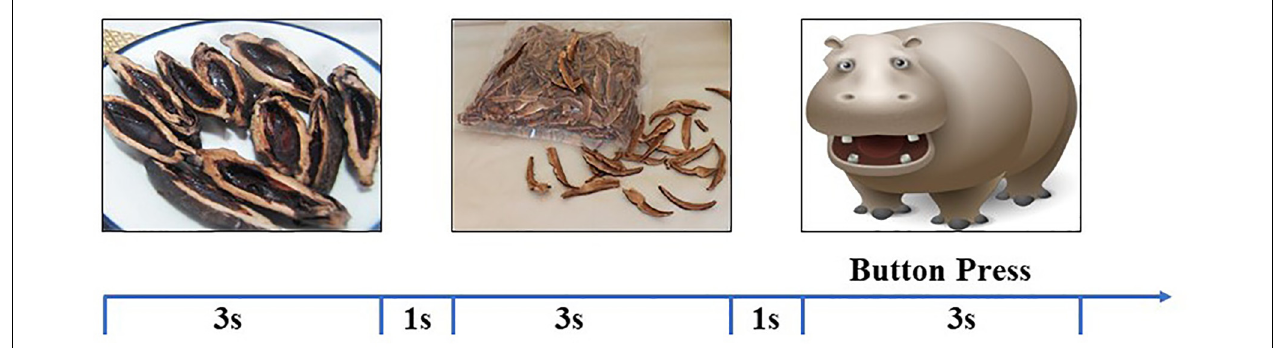
FIGURE 1 | The illustration of stimulus presentation. Different types of images [Betel quid (BQ), control, and animal] were randomly presented for 3 s with 1 s interstimulus interval. Participants were instructed to press a button when seeing an animal